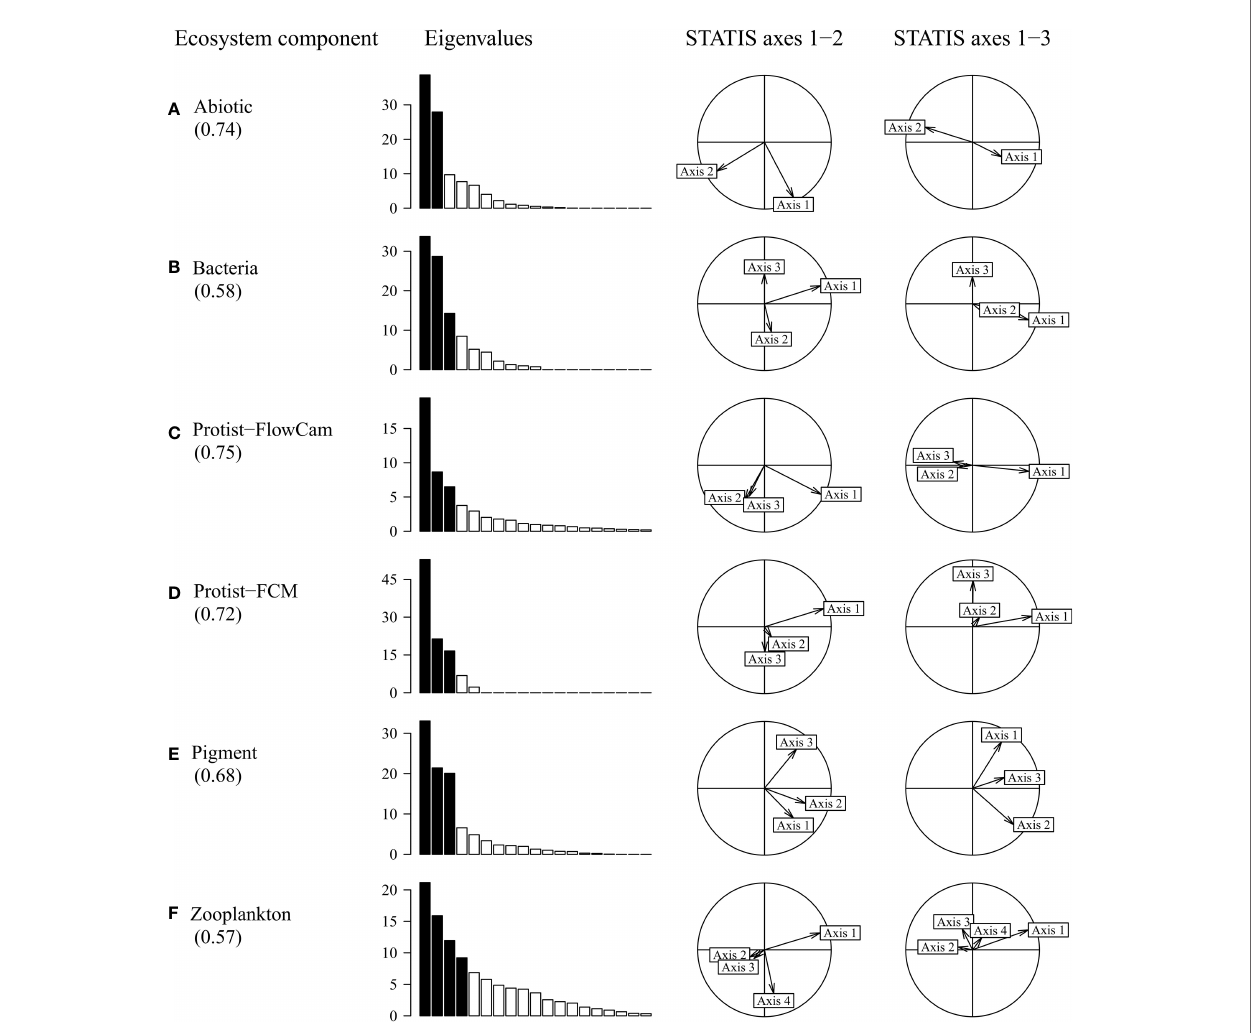
FIGURE 6 | Ecosystem component importance on the STATIS compromise axes. Values within parentheses below each component represent the RV -coef fi cients indicating the covariant part of the ecosystem component with the overall compromise ( fi tting between separate PCA axes and compromise axes). For each ecosystem component, the eigenvalue diagram (% of total inertia) indicates the dimensionality of the PCA data structure; black bars, most contributing axes. The correlation circles display the projections of these contributing axes (vectors) onto the three STATIS compromise axes (spatial patterns from Figures 5B – D ): Axis 1, horizontal; Axis 2, fi rst column, vertical; Axis 3, second column, vertical; the degree of PCA axis projection (i.e. vector length) indicates where the interpretation of individual variables is relevant in Figures 7 and 8